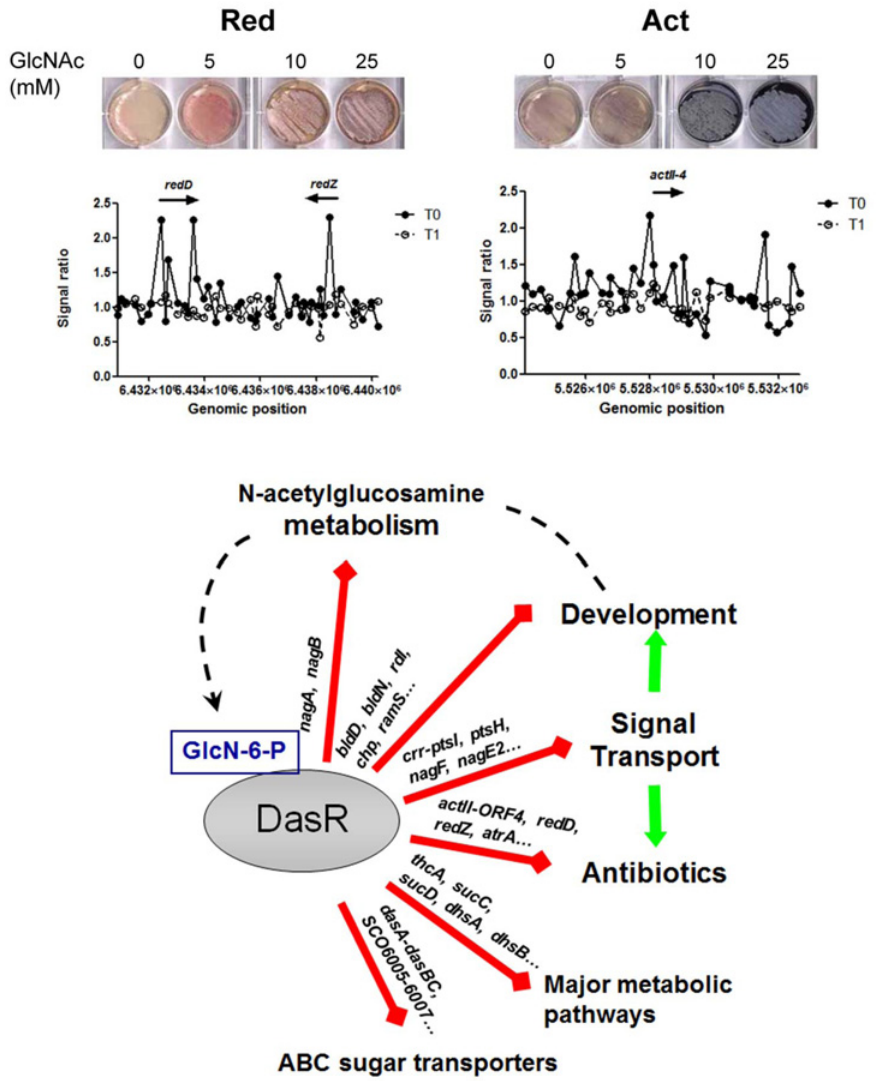
Fig 4. Model of the DasR regulon and its induction by N -acetylglucosamine. Top: induction of development (grey pigment) and Red (left; red pigment) or Act (right; blue pigment) production on MM agar plates with increasing concentrations of N -acetylglucosamine; the S . coelicolor actII -ORF4 (M510) and redD (M511) mutants [76] were used to demonstrate the production of only the red-pigmented undecylprodigiosin or the blue-pigmented actinorhodin, respectively. Middle, corresponding ChIP-chip experiments showing relief of DasR binding from the act and red regulatory genes in vivo after the addition of GlcNAc (examples taken from Fig 2). T 0 (closed circles) and T 1 (open circles), time points before and 30 min after the addition of 25 mM GlcNAc; respectively. Bottom, summary of the DasR-controlled processes and major targets that are directly or indirectly controlled by DasR. Red lines indicate direct binding and transcriptional repression of the target genes by DasR (for some developmental genes only based on ChIP-on-chip data). Derepression of control by DasR in response to the accumulation of GlcN-6P results in activation (green lines) of morphological development and antibiotic production, among other